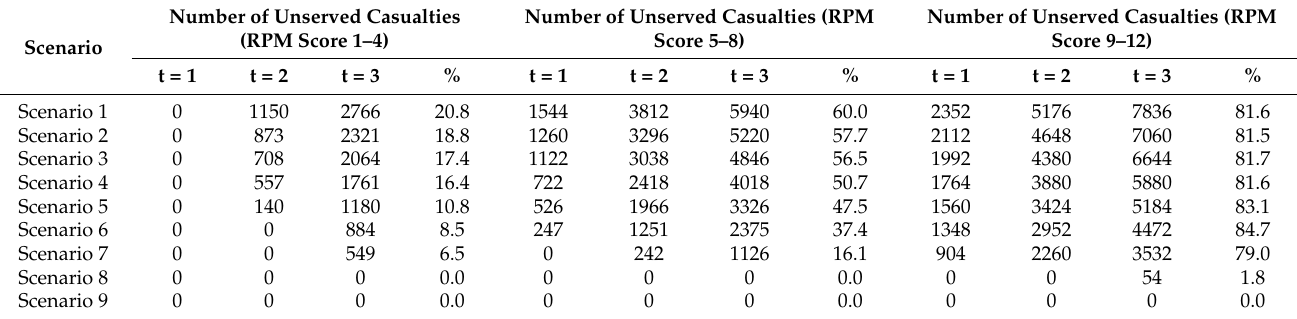
Table 4. The number of unserved casualties by RPM value and period of the 26th solution based on scenarios. Number of Unserved Casualties (RPM Score Scenario